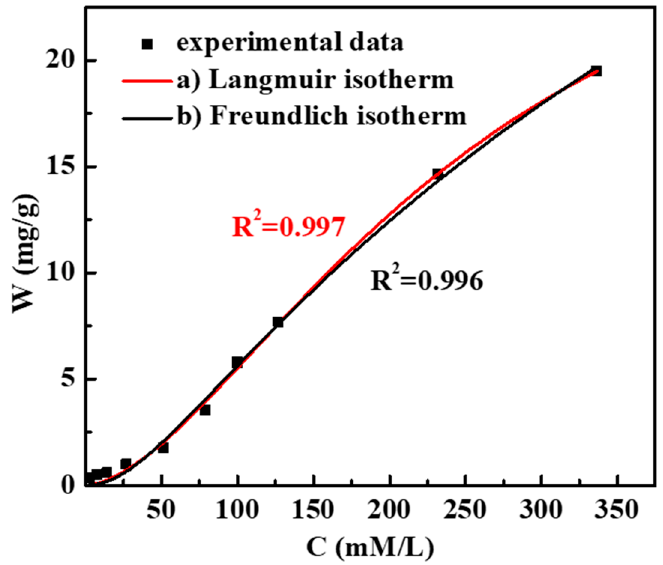
Figure 4. Isotherm of chloride adsorption by PAMC in NaCl solution at 25 ℃ .